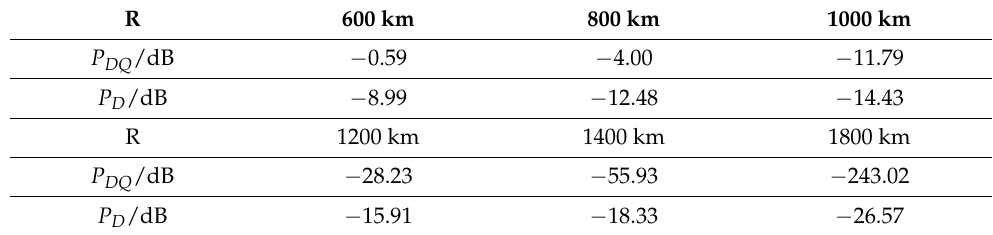
Table 1. Average quantum and conventional radar detection probability at different distances.